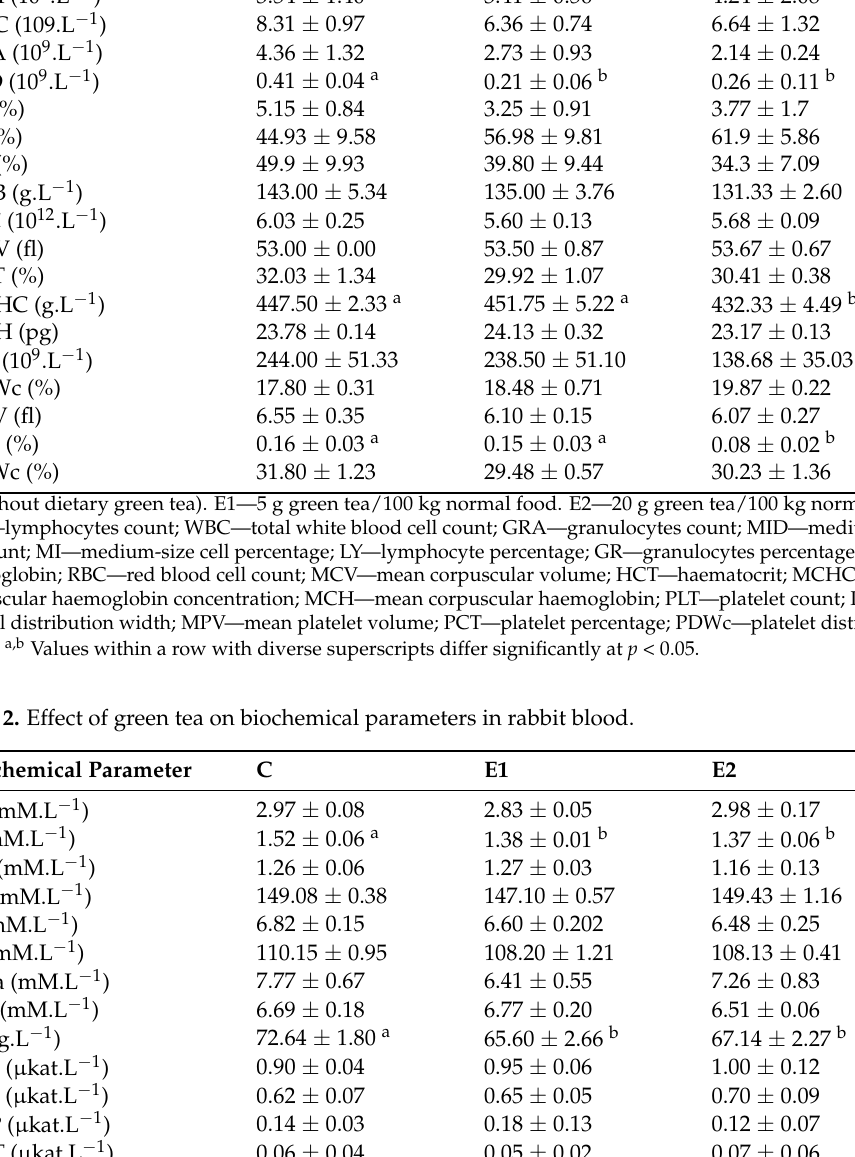
Table 1. Effect of green tea on haematological parameters of rabbit blood. Haematological Parameter